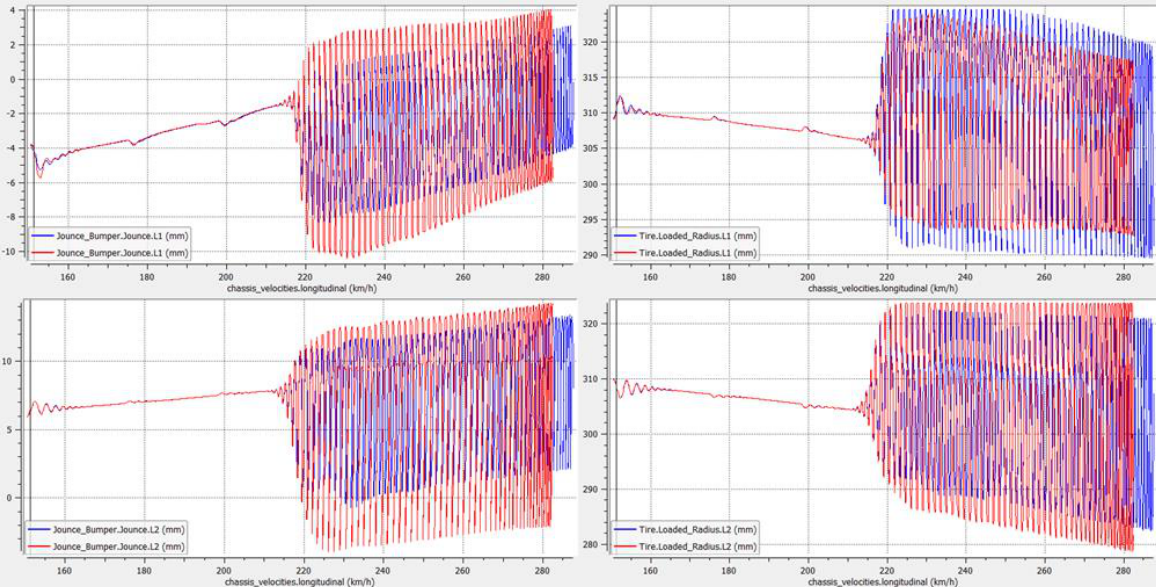
Figure 20. Increased front damping (blue plot) also reduces the amplitude of front suspension jounce ( left plots for front and rear axle), the tire deflection is however increased ( right plots for front and rear axle). Both amplitudes are reduced at the rear end. Frequencies are basically unal- tered.